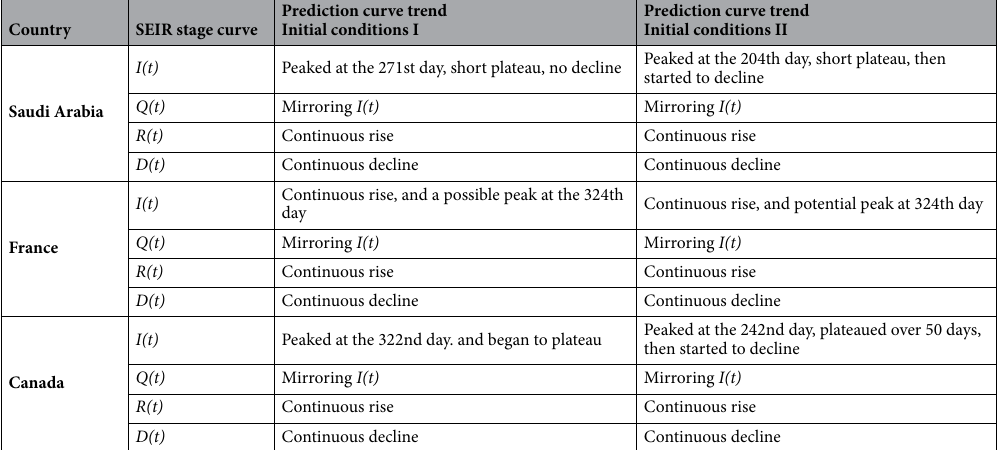
Table 3. E- SEIR model prediction curves trends summary for Saudi Arabia, France, and Canada.